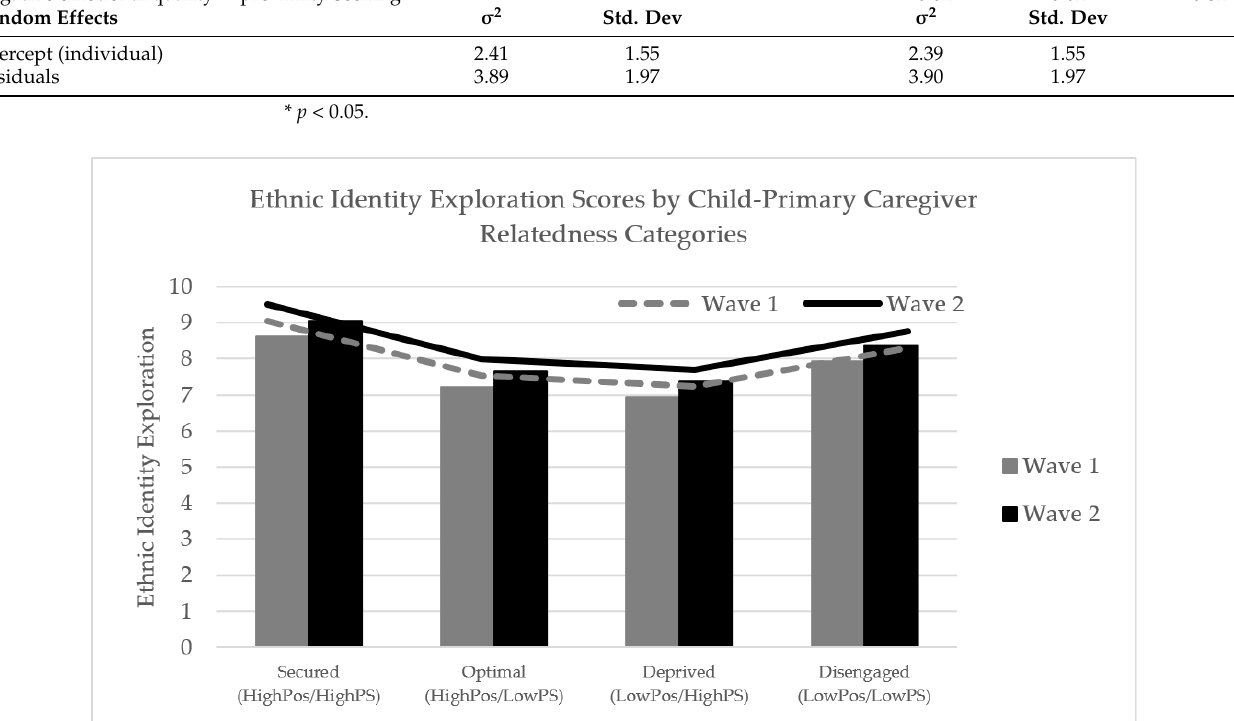
Figure 2. Ethnic identity exploration scores, according to primary caregiver relationship categories.